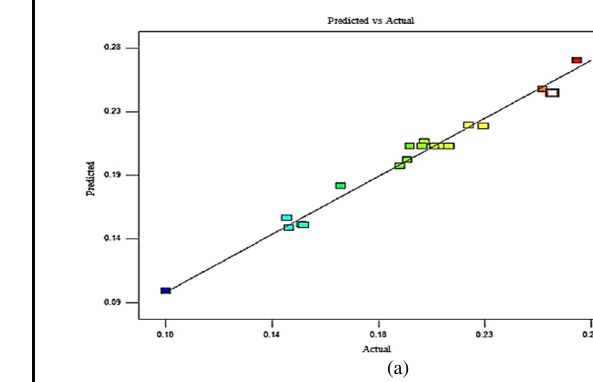
Fig. 4: Normal Plot of Residuals for (a) Ra and (b)